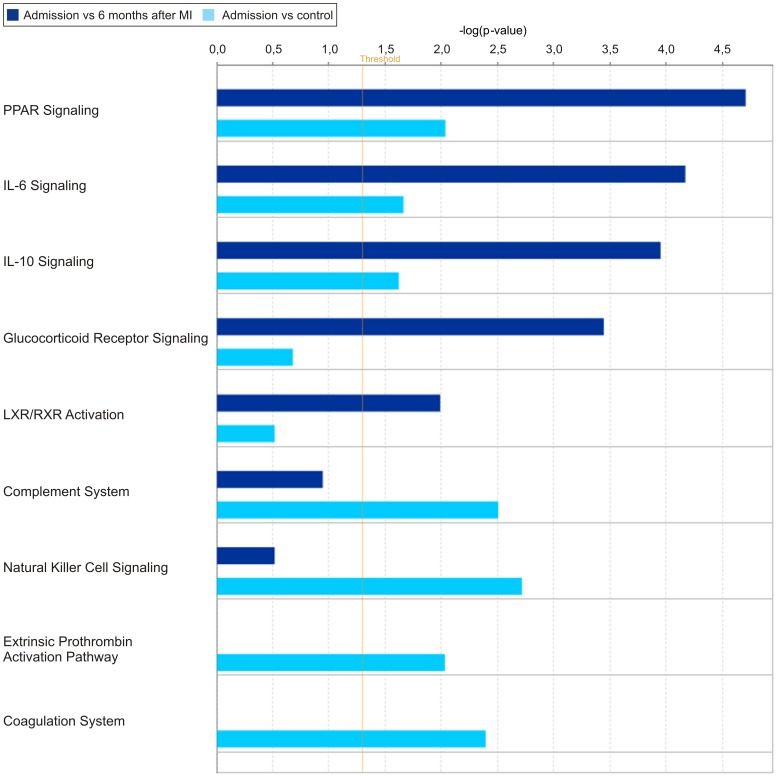
Top canonical pathways associated with acute phase of STEMI.Ingenuity Pathway Analysis of gene sets differentially expressed on the first day of myocardial infarction versus 6 months after MI or versus control group was performed. Functional categories are represented on the x-axis. The significance is expressed as the negative exponent on the p-value calculated for each function on the y-axis of the diagram, increasing with bar height.